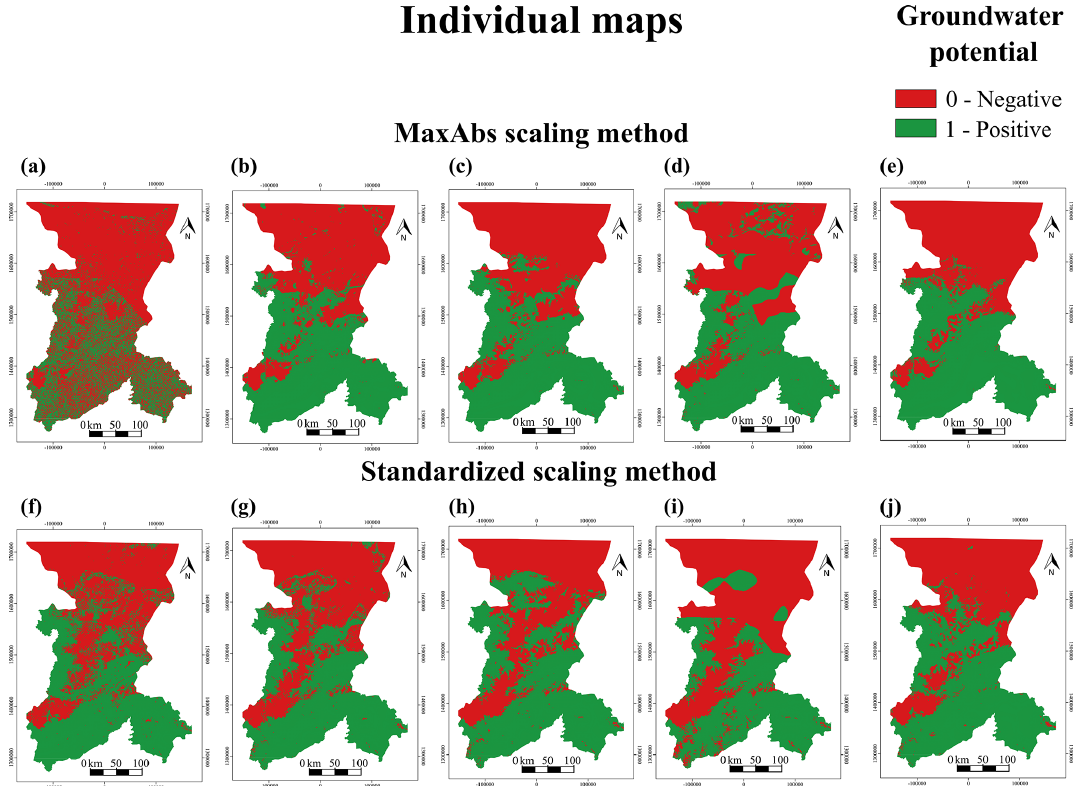
Figure 10. Mapping outcomes of the top five supervised classification algorithms for the two best-performing scaling methods. The top row shows the MaxAbs scaling method for the (a) AdaBoost classifier, (b) gradient boosting classifier, (c) random forest classifier, (d) decision tree classifier and (e) extra trees classifier. The bottom row shows the standardized scaling method for the (f) AdaBoost classifier, (g) gradient boosting classifier, (h) random forest classifier, (i) decision tree classifier and (j) extra trees classifier.